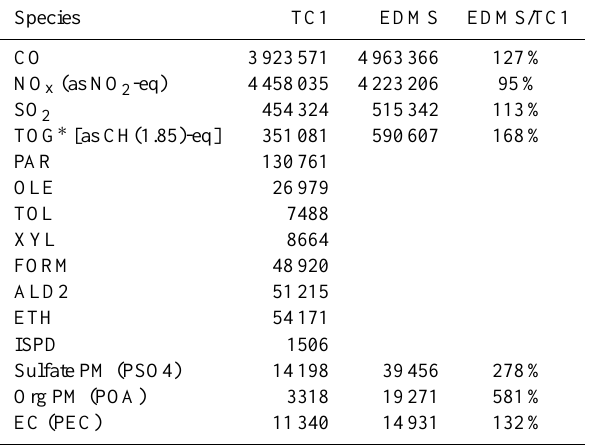
Table 1. Comparison of total annual aircraft emissions (in kg) from the Atlanta airport at altitudes below 1000m for TC1- and EDMS- derived emissions used in Arunachalam et al. (2008,